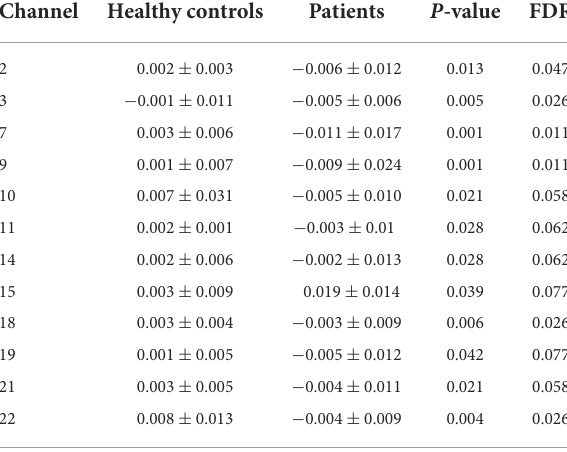
TABLE 4 The β values during 2-back tasks in patients and healthy controls.